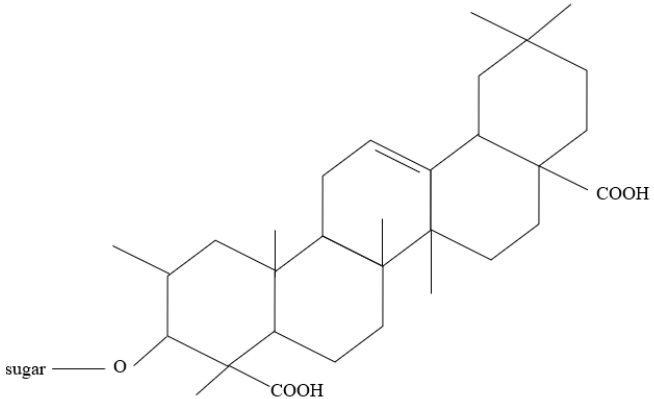
Figure 11. Chemical structure of saponins.